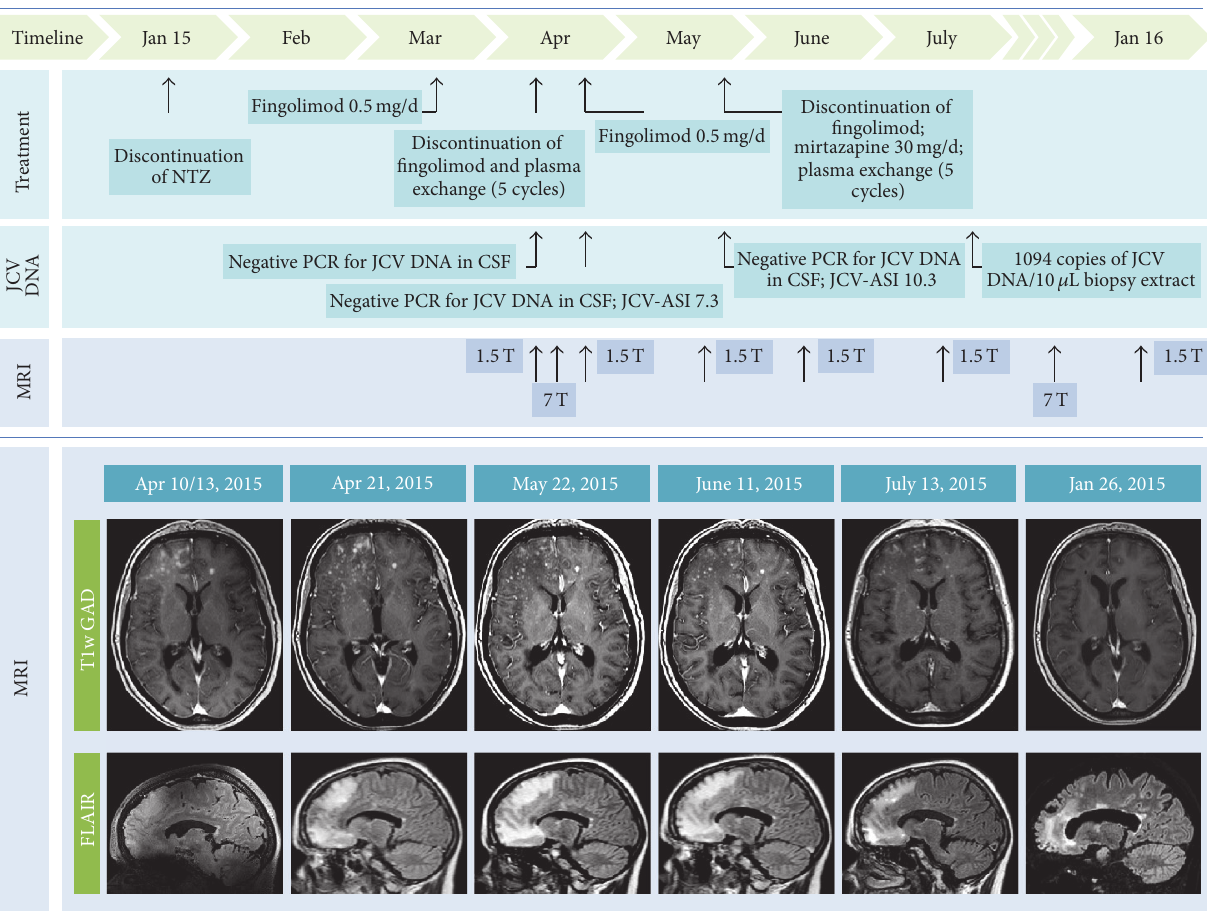
Figure1:Overview.SurveyoftreatmentdecisionsandlaboratoryandMRIfindingsofthepatientunderdiscussion.Indetail,1.5 TT1weighted Gadolinium enhanced (T1W GAD) and 1.5T fluid attenuated inversion recovery (FLAIR) images are